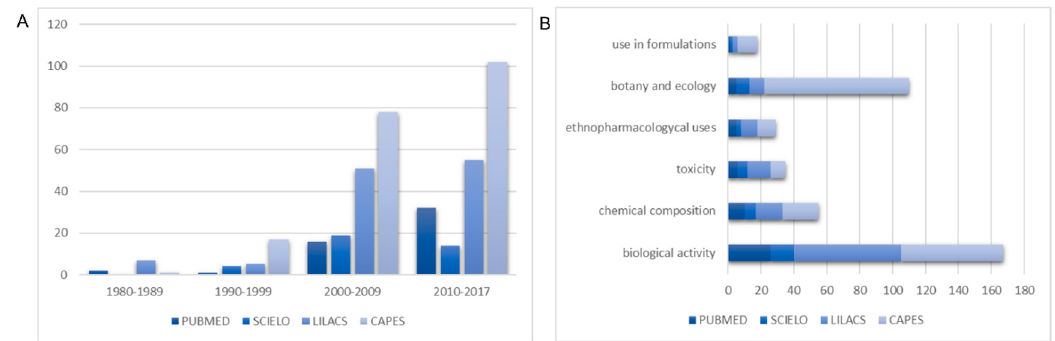
Figure 1. Number of publications in the searched databases according year ( A ) and research area ( B ).